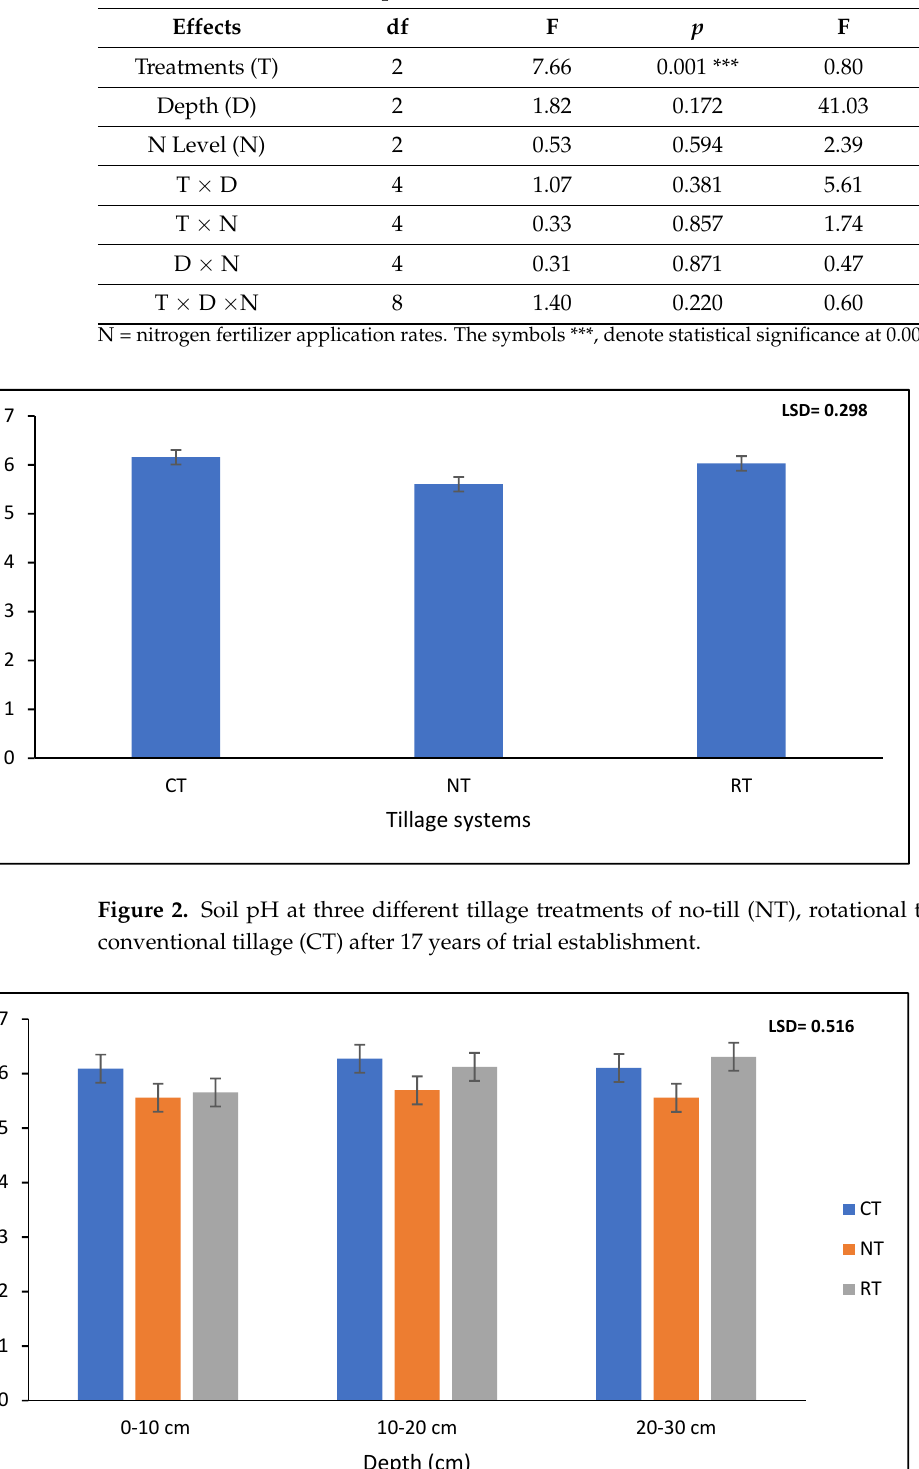
Table 2. ANOVA results of the effect of tillage treatments (NT, RT, and CT), depth (0–10, 10–20, and 20–30 cm), N-levels (0, 100, 200 kg/ha), and their interaction on soil pH and SOC.